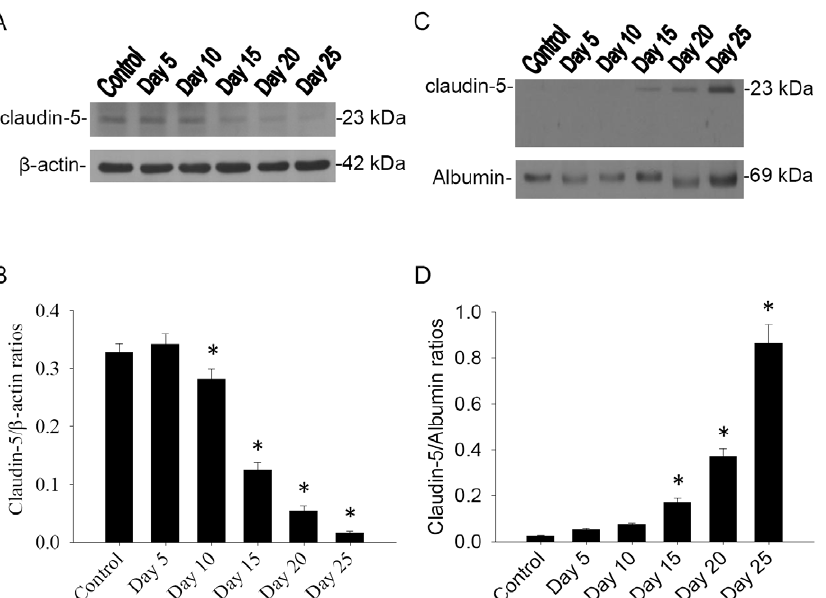
Figure 2. Time-course studies for claudin-5 in mouse brain and CSF. Protein bands of (A) brain claudin-5 and (C) CSF claudin-5 from mice (n=5) infected with A. cantonensis . b -actin and albumin were used as loading control. (B and D) Quantification and normalization to loading control of claudin-5 showed significant decrease (* P , 0.05) in brain but significant increase in CSF (* P , 0.05). Bars represent mean 6 S.D. from three independent experiments performed in